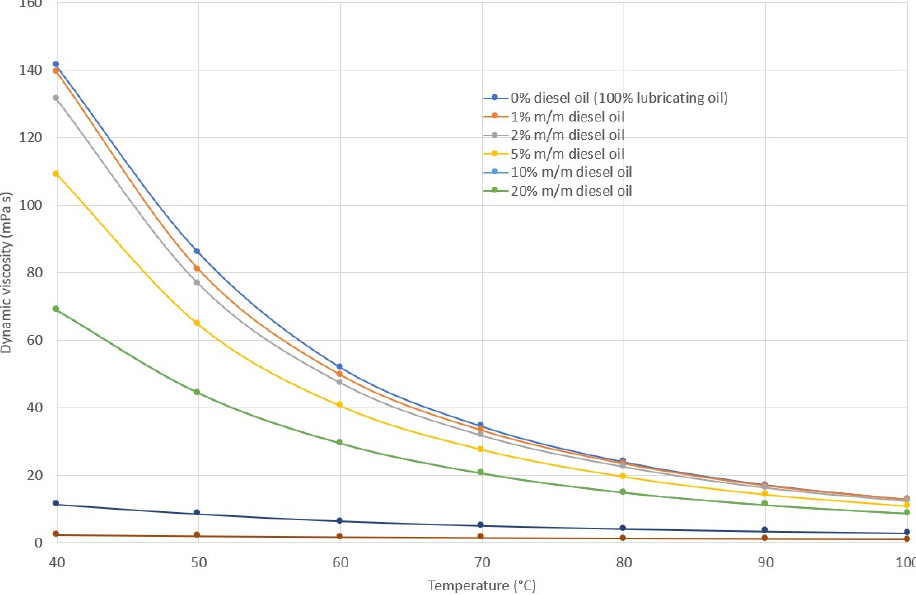
Figure 17. Measured values of dynamic viscosity of SAE 40 class oil in the temperature range of 40–100 °C at different levels of lubricating oil dilution with diesel fuel.